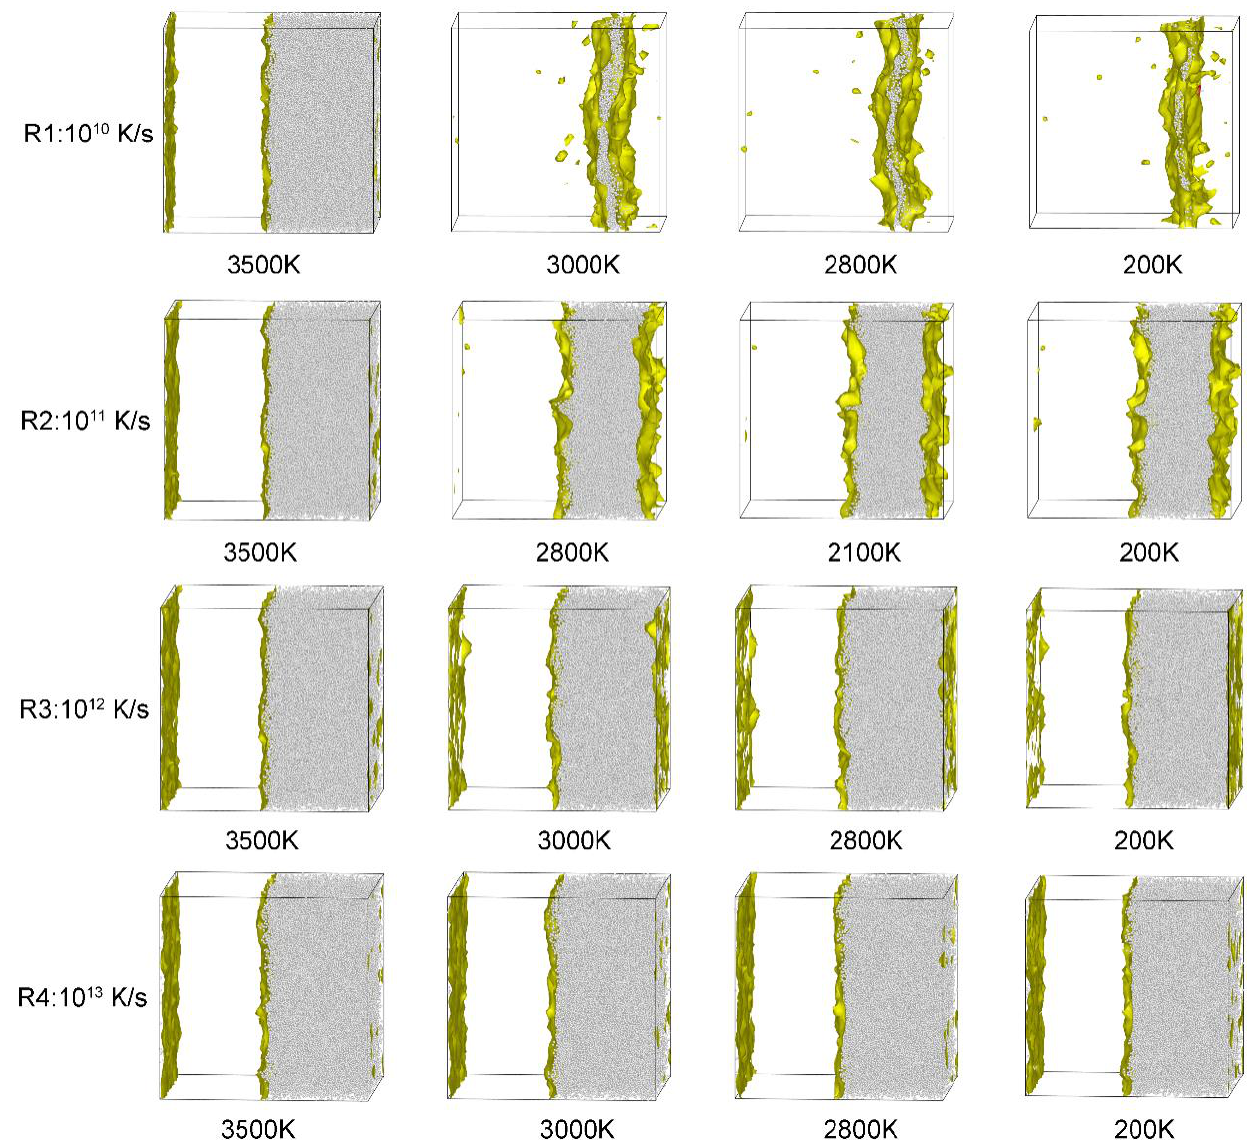
Figure 9. The position change of solid – liquid interface under different cooling rates (gray represents liquid atoms, and yellow shadows represent solid – liquid interface locations).